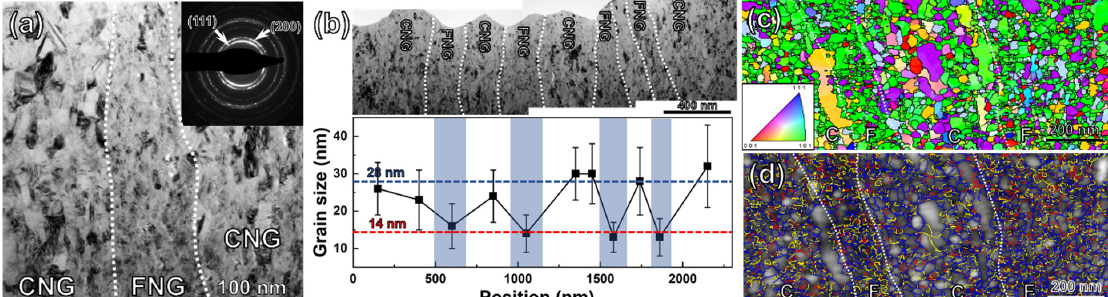
Figure 2. ( a ) TEM image showing the formation of an NG structure in the topmost region of the IN718 specimen after surface mechanical grinding treatment (SMGT). Fine nanograin (FNG) layers were sandwiched by coarse nanograin (CNG) layers. ( b ) TEM image of NG region and the corresponding grain size vs. position profile showing the grain size evolution of both FNG and CNG layers at various depth. The corresponding ( c ) ASTAR crystal orientation analyses and ( d ) grain boundary map showing the high-angle grain boundaries (blue lines), low-angle grain boundaries (red lines) and twin boundaries (yellow lines).